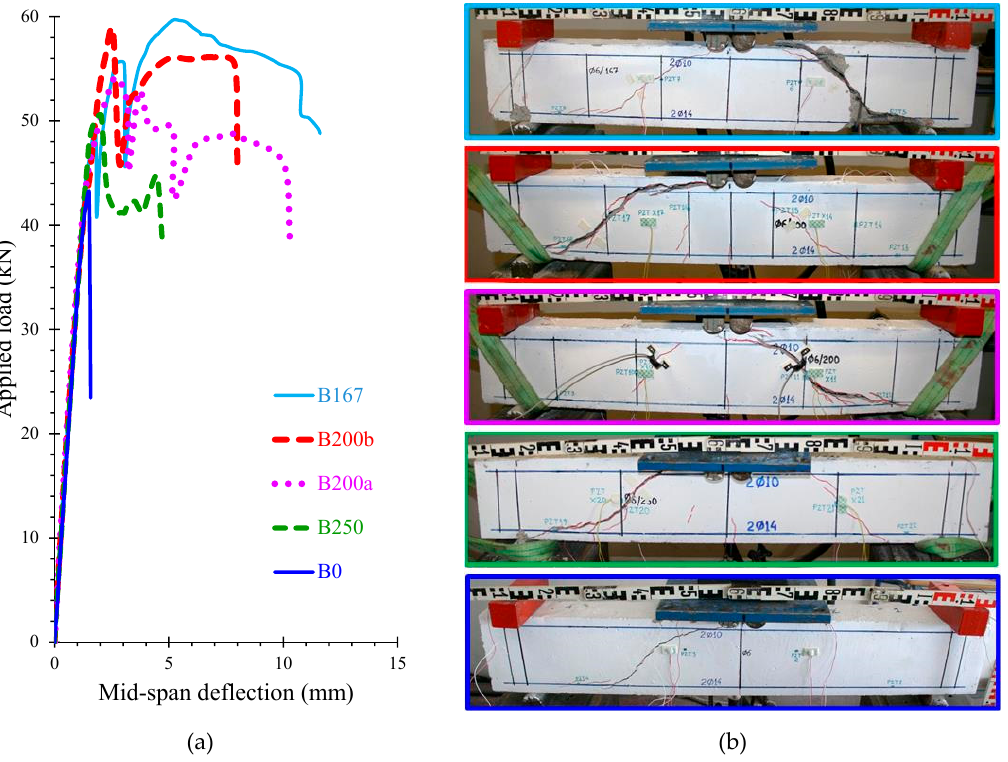
Figure 3. ( a ) Experimental behavior of the initially tested shear-critical beams in terms of applied load versus mid-span deflection; ( b ) cracking patterns at failure.